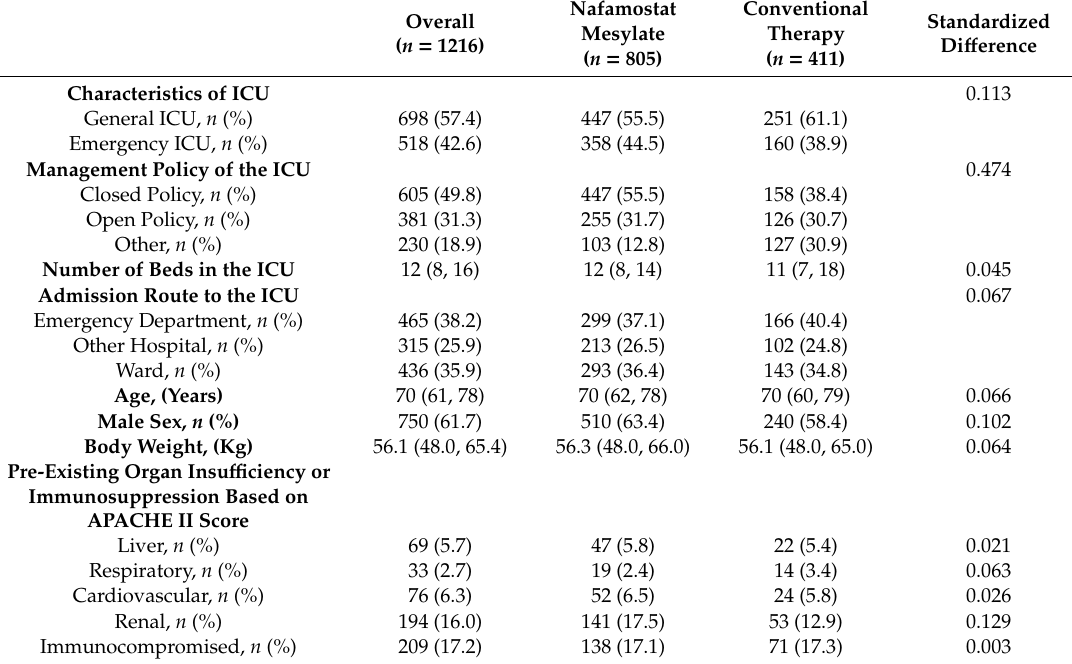
Patient characteristics and treatments in the nafamostat mesylate and conventional therapy